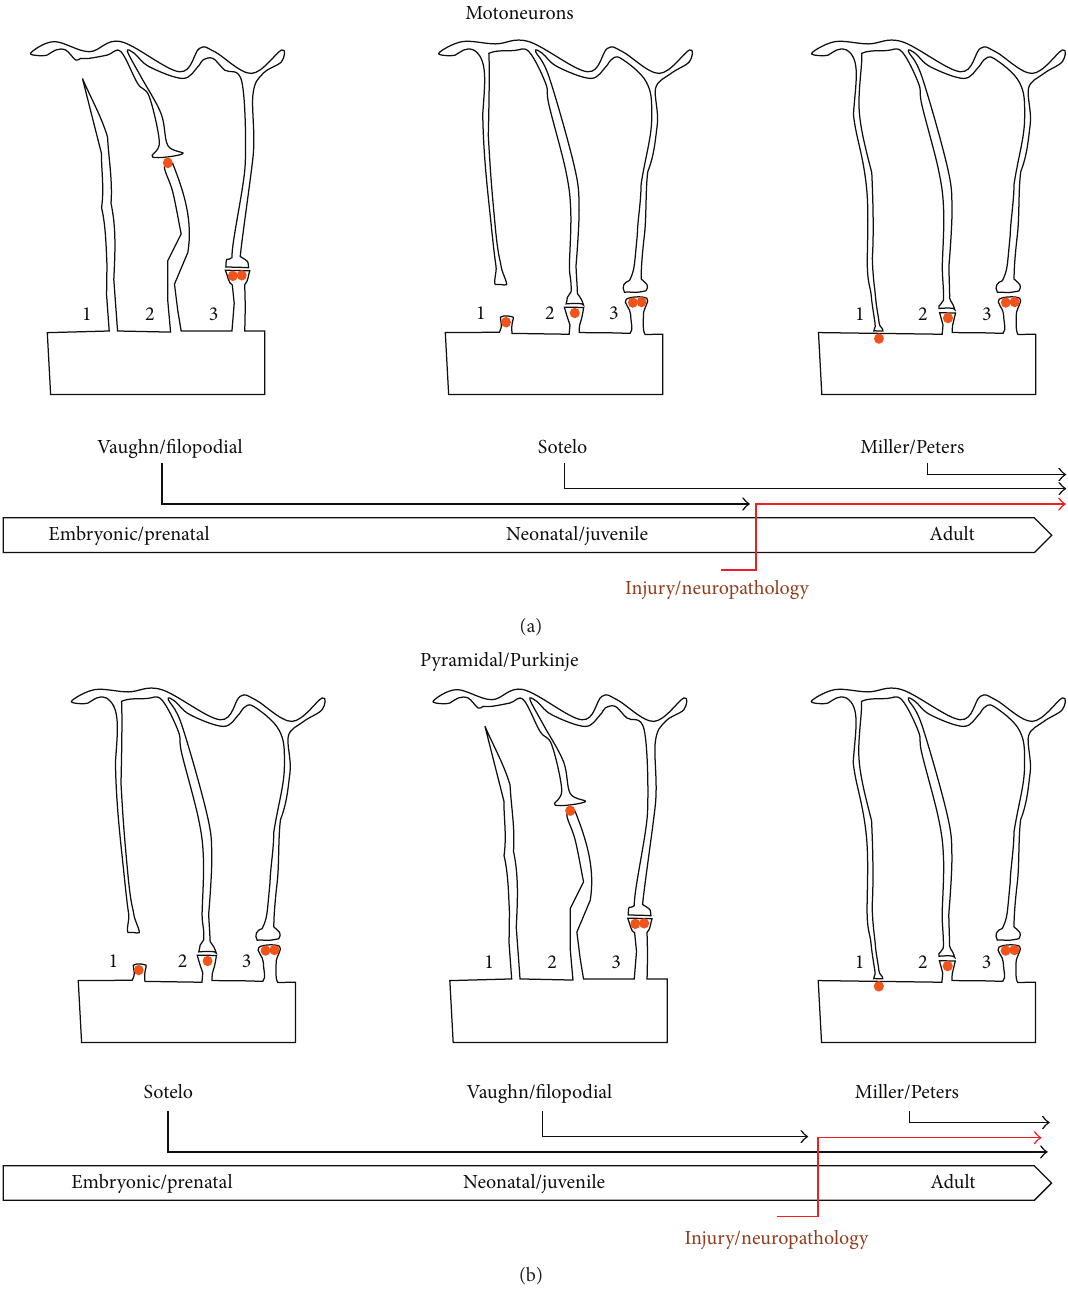
Figure 8: A schematic presentation of a unified-hybrid model of spinogenesis/synaptogenesis in motoneurons compared to pyrami- dal/Purkinje neurons at different developmental stages involving previously described models. (a) In motoneurons, the Vaughn/filopodial model (left) predominates during embryonic, prenatal, and neonatal development but becomes less common during juvenile development, where the Sotelo model (middle) becomes more frequent. The Miller/Peters model (right) may play a role in adult plasticity. (b) The sequence of spinogenesis/synaptogenesis in motoneurons seems to significantly differ from that described for pyramidal and Purkinje cells. The Sotelo model predominates in spinogenesis in pyramidal/Purkinje cells during embryonic/prenatal period. The filopodial model is less involved in all cell types in the adult but is likely reactivated as part of the regenerative/remodelling processes following injury/neuropathological conditions (red lines). 1, 2, and 3 indicate the sequence of pre- and postsynaptic development; filled circles represent postsynaptic receptor